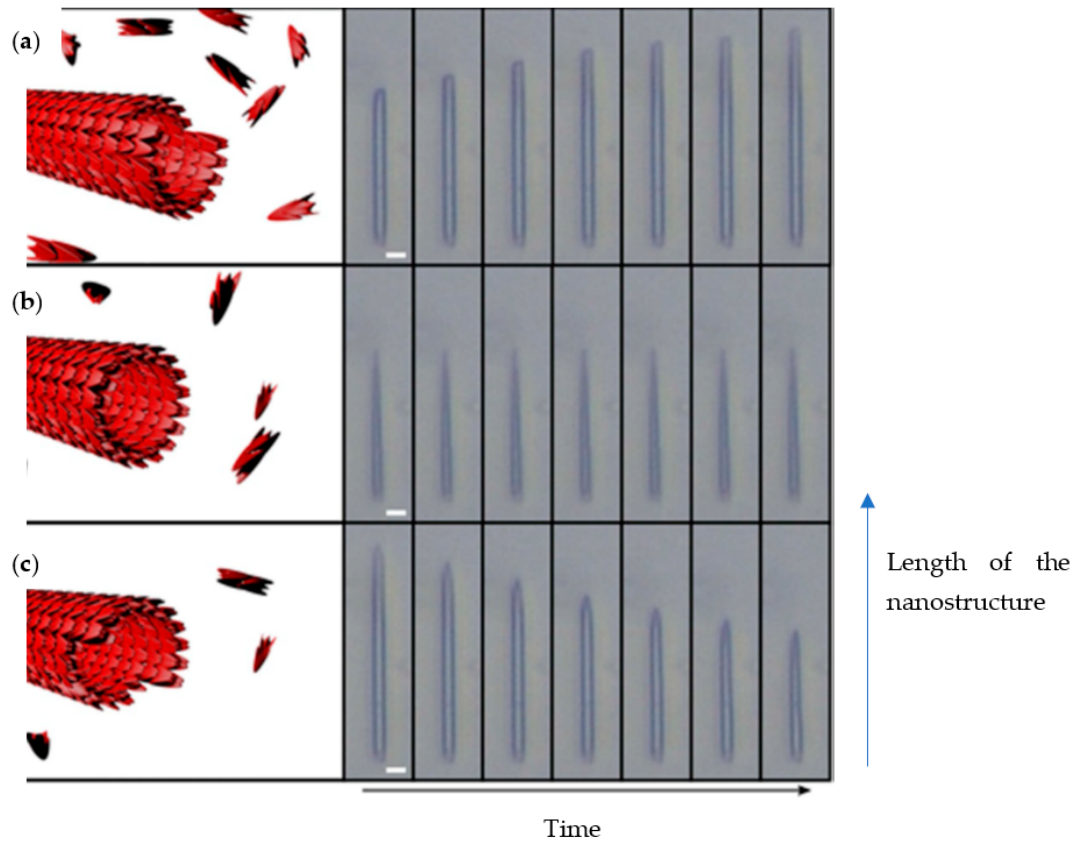
Figure 4. Elongation or shortening of FF nanotubes depending on monomer concentration in microfluidic platform. ( a ) supercritical concentration, ( b ) critical concentration, ( c ) subcritical concentration. Adapted with permission from Reference [33].